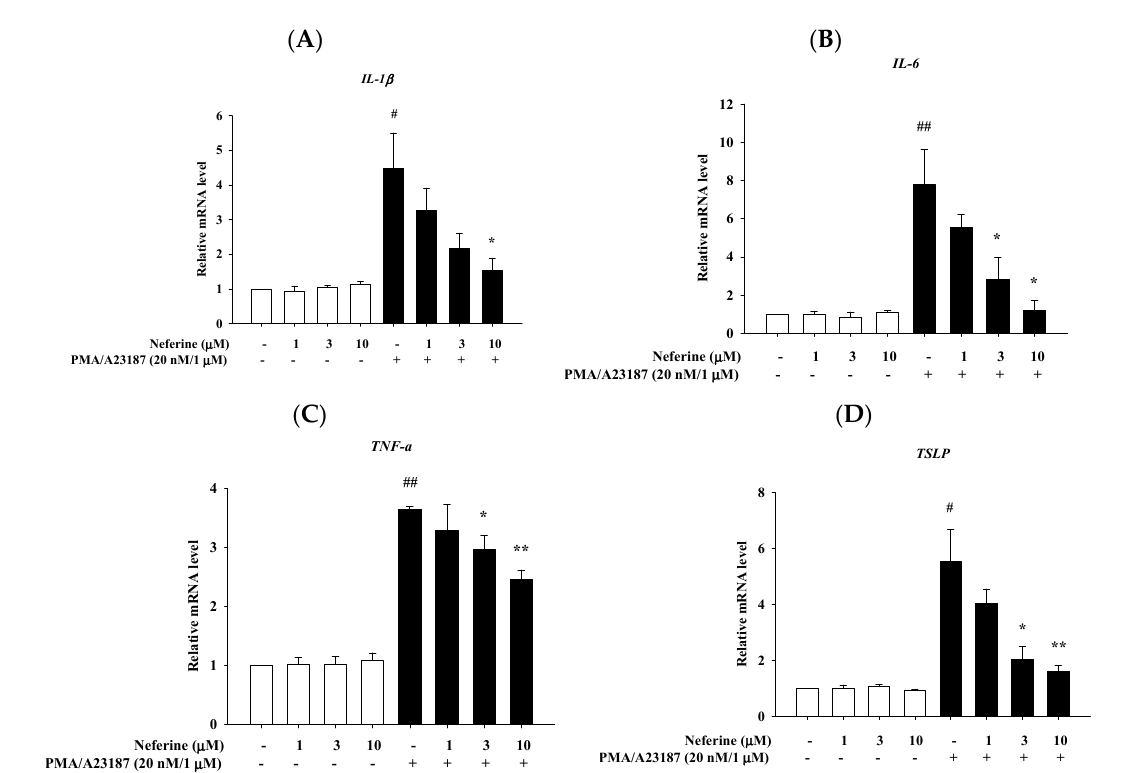
Figure 4. The effects of neferine on the mRNA expression levels of cytokines in PMA/A23187-stimulated RBL-2H3. RBL- 2H3 cells were pretreated with different concentrations of neferine—1, 3, and 10 μ M—for 20 min, and then the cells were treated with PMA/A23187 (20 nM/1 µ M) for 6 h. Total RNA was isolated and mRNA expression level of ( A ) IL-1 β , ( B ) IL-6, ( C ) TNF- α , and ( D ) TSLP were determined using qPCR. Values represent the mean ± SEM from the three independent experiments. # p < 0.05, ## p < 0.01 compared with the no-treatment condition, * p < 0.05, ** p < 0.01 compared with the only TNF- α /IFN- γ treatment condition.